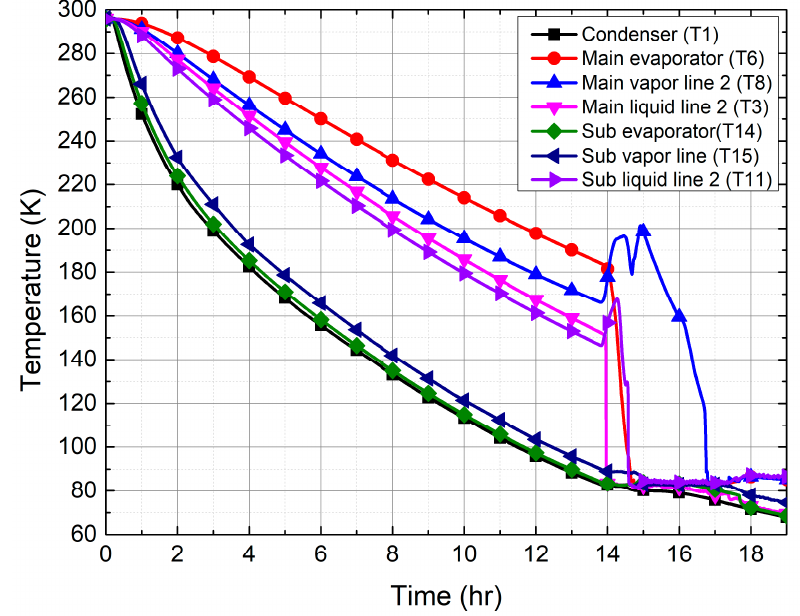
Figure 7. Supercritical start-up and temperature change over time of the CLHP, from room temperature to cryogenic temperature.